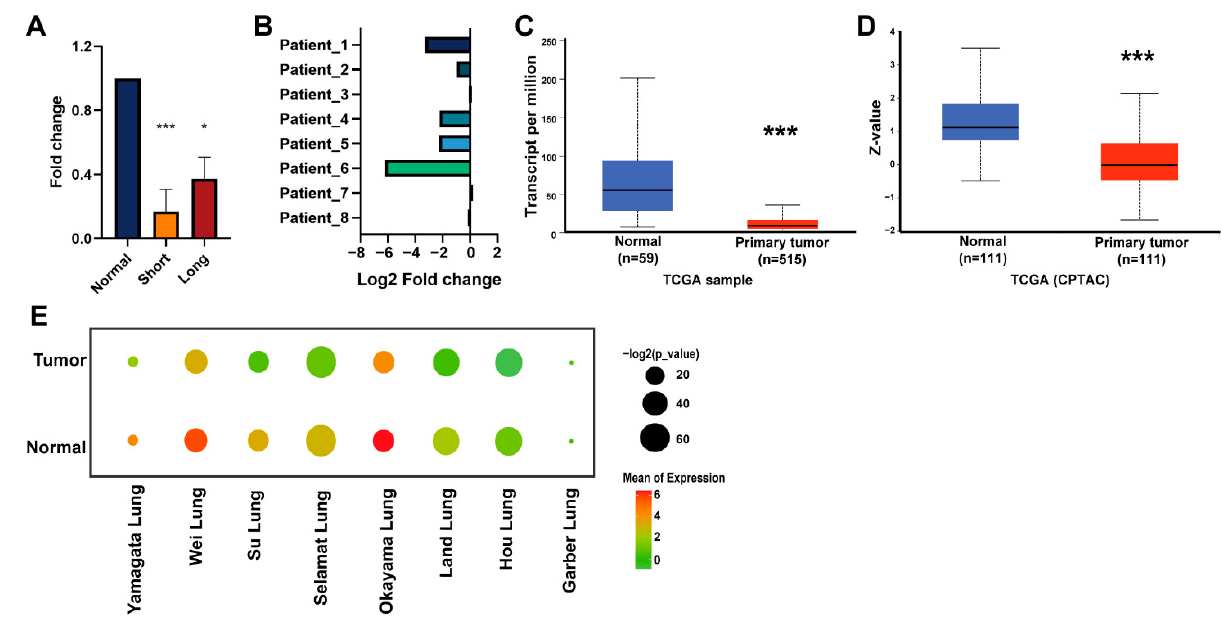
Figure 1. The expression of ADAMTS1 in lung adenocarcinoma ( LUAD ) . ( A ) Fold change of ADAMTS1 expression from the lung cancer cells H2087 cultured in normoxia and hypoxia con- ditions for 24 h (short) or 100 days (long). The RNA levels of ADAMTS1 were determined by qRT − PCR. ( B ) Fold change of ADAMTS1 expression in the paired tumor and normal tissue from eight patients with LUAD (in − house cohort). ADAMTS1 mRNA ( C ) and protein ( D ) expression in the normal tissue and tumor from TCGA cohort. ( E ) ADAMTS1 mRNA expression in the normal tissue and tumor of eight datasets from the Oncomine datasets. Data shown represent the mean ± SD (* p < 0.05, *** p < 0.001).